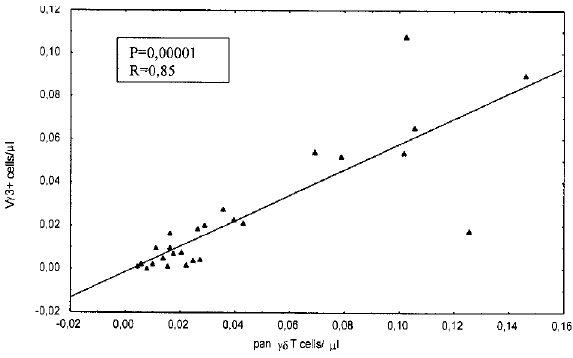
FIG. 1. Correlation between pan g d + T cells number and the number of V d 3 + cells in SLE